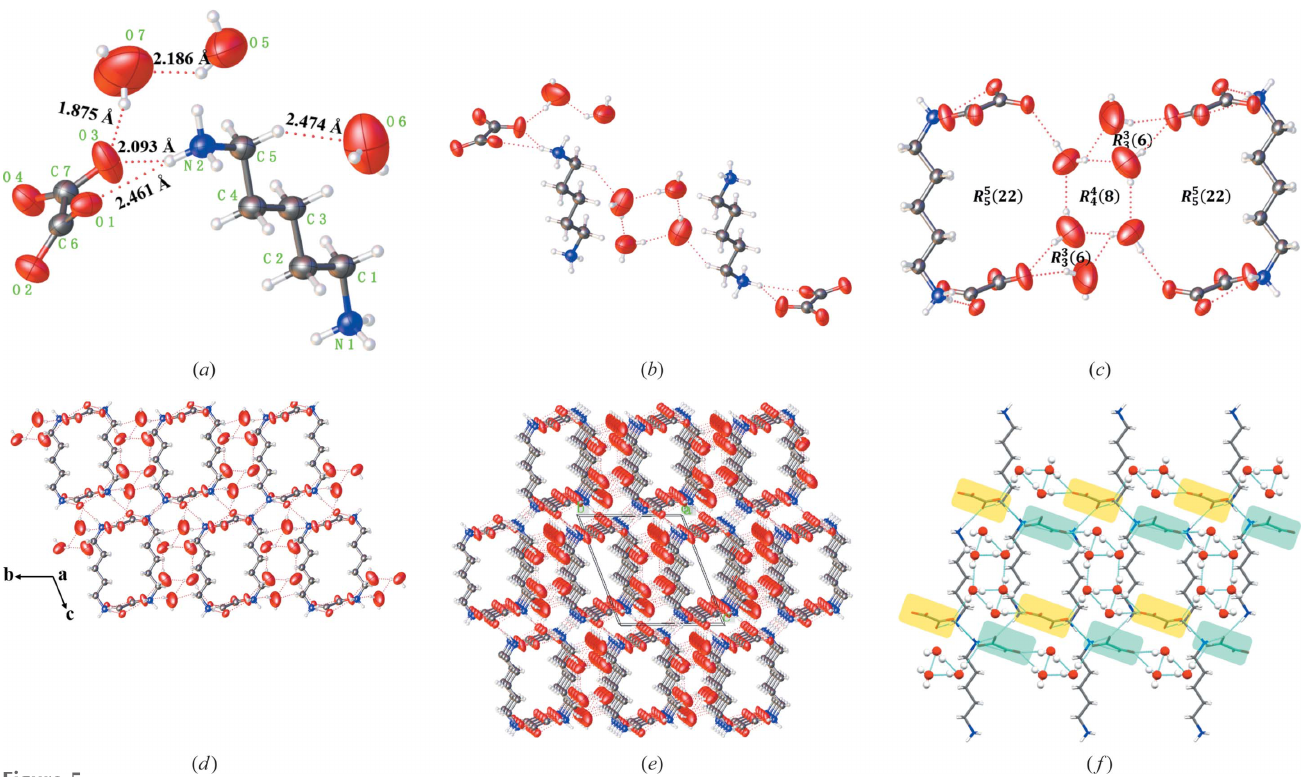
Figure 5 ( a ) Asymmetric unit with the selected atom-labeling scheme for the trihydrate. The ellipsoids are shown at 50% probability. ( b ) Crystal structure of a dinuclear unit of the trihydrate. ( c ) View of the packing structure of the trihydrate with hydrogen bonds between the coordinated water and PDA-OXA (dashed lines). ( d ) and ( e ) 3D supramolecular framework of trihydrate with an open 1D channel and packing diagrams along the a axis, respectively. ( f ) The reverse arrangement of OXA molecules shown in green and yellow.